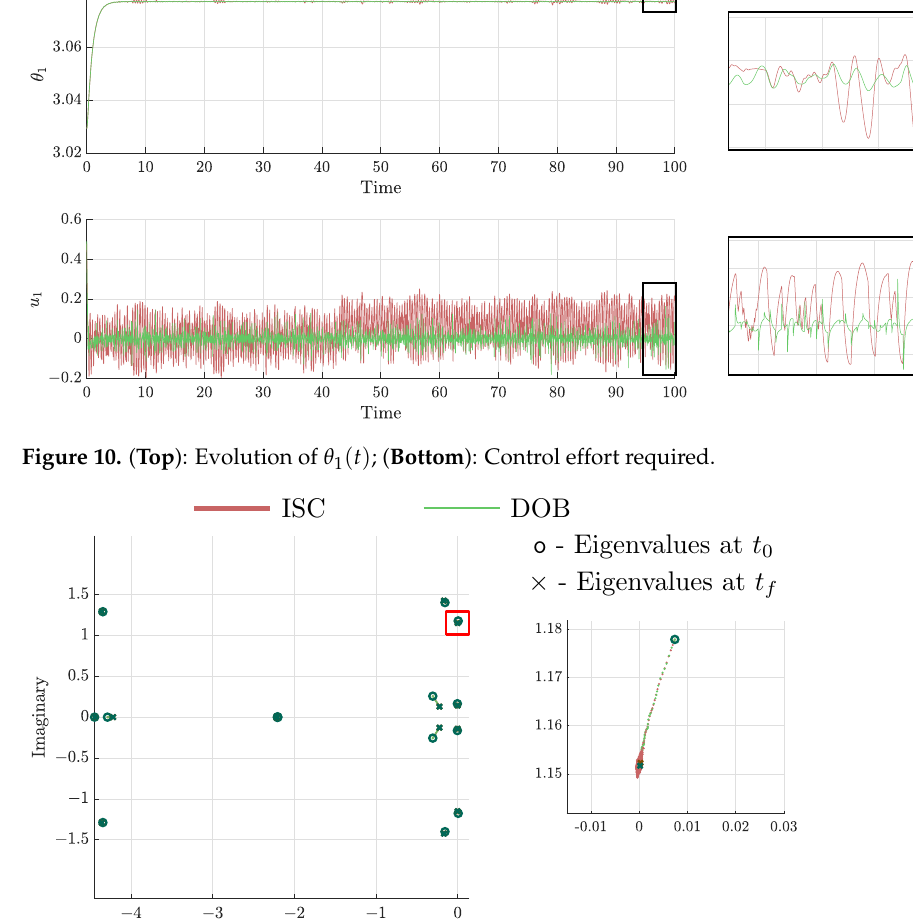
Figure 11. Eigenvalues of agent 1 evolution under ISC and DOB.